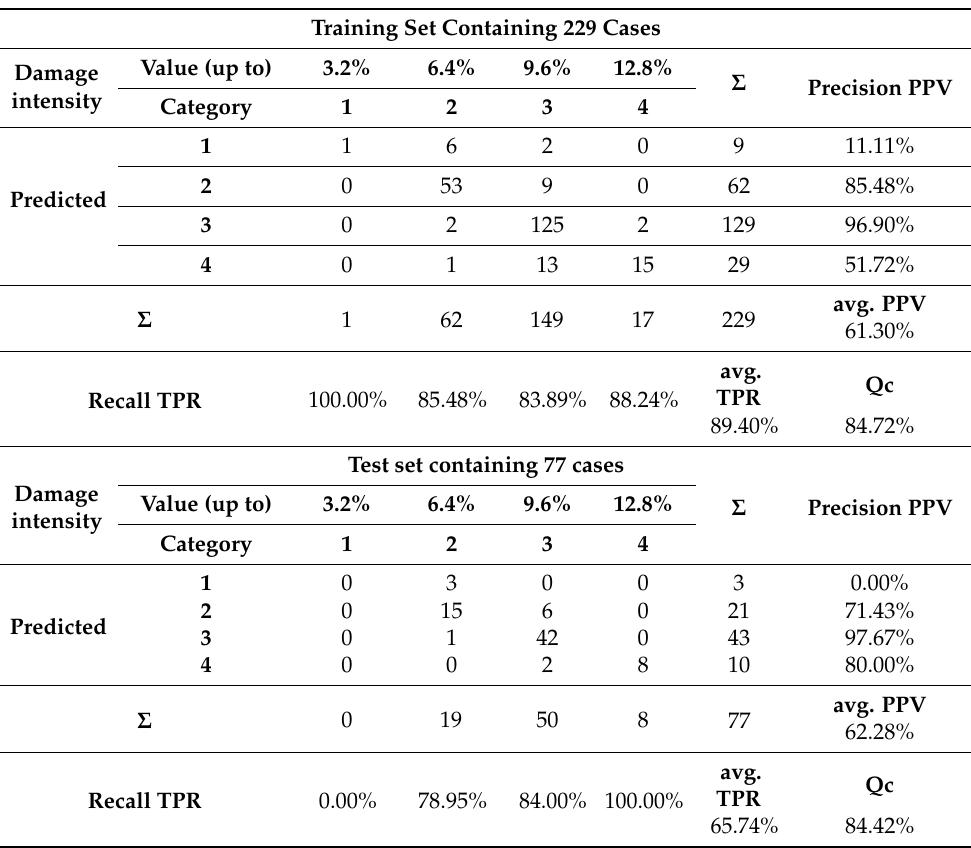
Table 5. Confusion matrix for the SVM classifier—quality of classification, average precision, and average recall for training and test